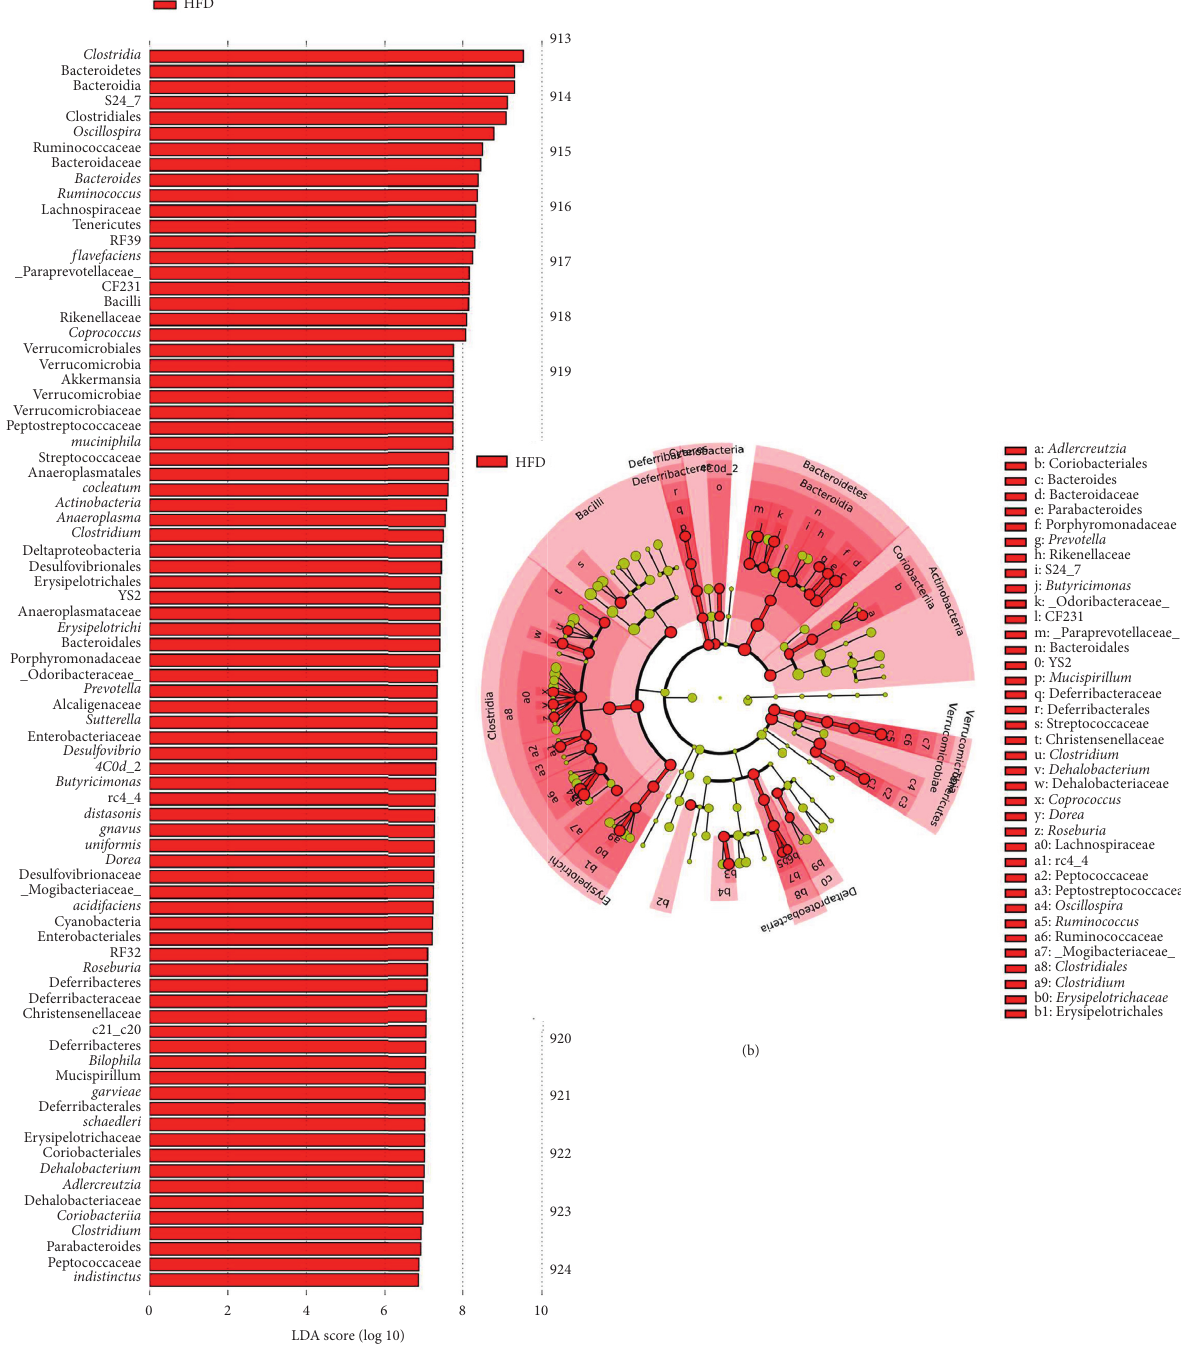
Figure 7: Effects of low-dose OMC on taxa abundance in rats fed HFD for 10 weeks. (a) Linear discriminate analysis of effect size (LEfSe) results depicting different microbial taxonomic signatures in fecal samples collected from male Sprague-Dawley rats fed a 10-week HFD ( n � 6/group) in comparison to HFD-fed rats treated with 0.6mg/mL OMC for 10 weeks. No other differences were detected. (b) Cladogram depicting differentially abundant microbial taxa in stool samples collected from male Sprague-Dawley rats fed HFD ( n � 5-6/group) for 10 weeks. Microbial taxa enriched in HFD rats are shown in